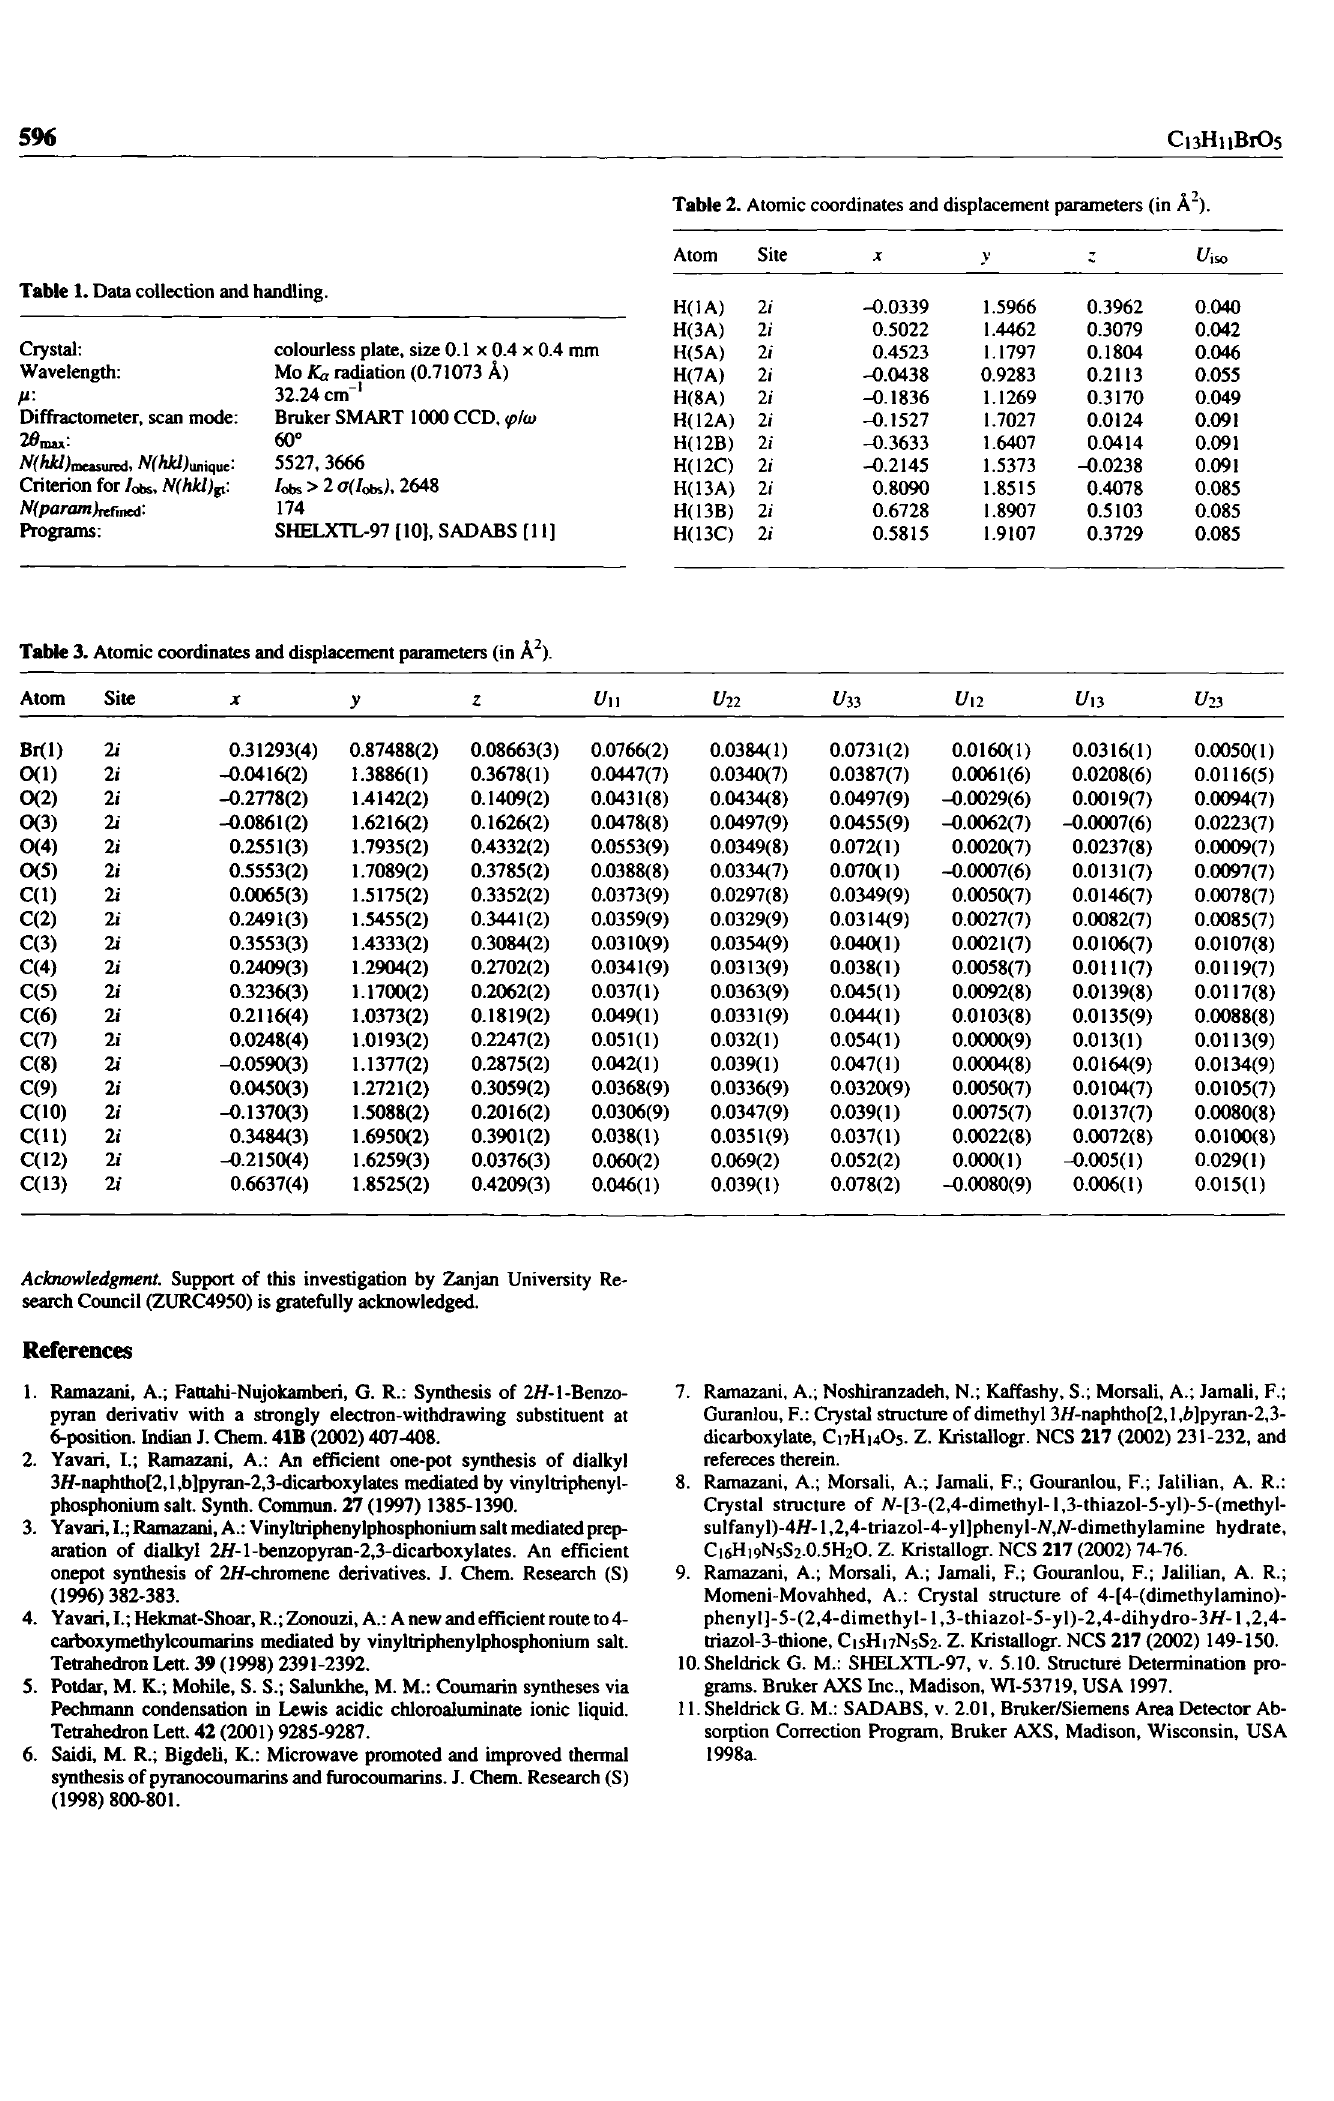
Table 1. Data collection and handling.